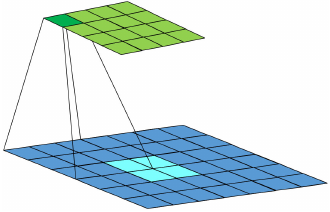
Figure 5. Transposed convolution operation.